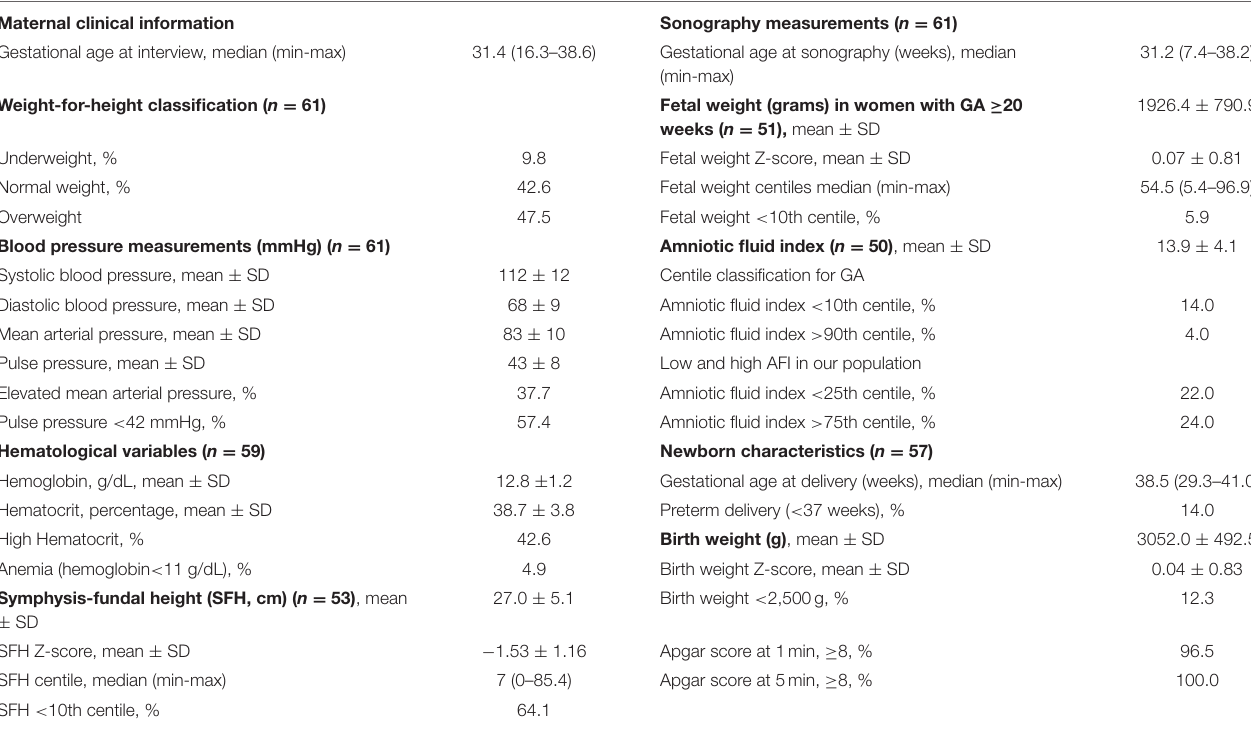
TABLE 2 | Maternal and fetal health indicators. Maternal clinical information